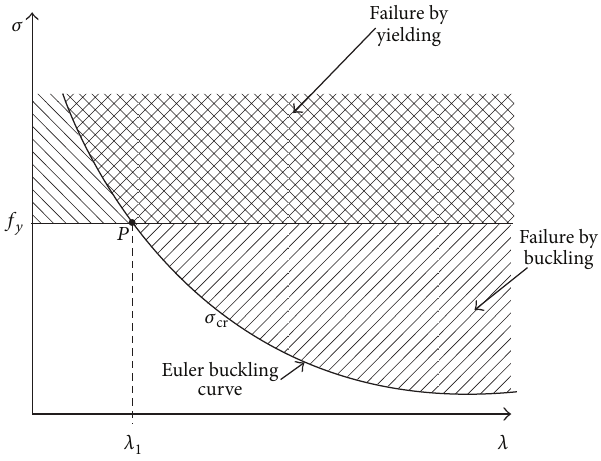
Figure 15: The relationship between buckling strength and slender- ness ratio depends on the support conditions at the column ends [11].